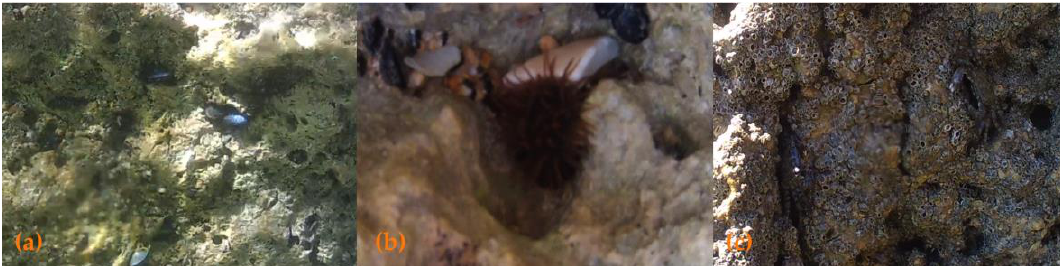
Figure 10. ( a ) Start of a community of mussels ( Mytilus spp. Linnaeus (1758)) on a surface where barnacles ( Chthamalus spp. Ranzani (1817)) also abound; ( b ) anemone specimen ( Actinia equina Linnaeus (1758)) and ( c ) two specimens of crab ( Pachygrapsus spp. Randall (1839)) on a surface with barnacles ( Chthamalus spp. Ranzani (1817)) and some limpets ( Patella spp. Linnaeus (1758)).